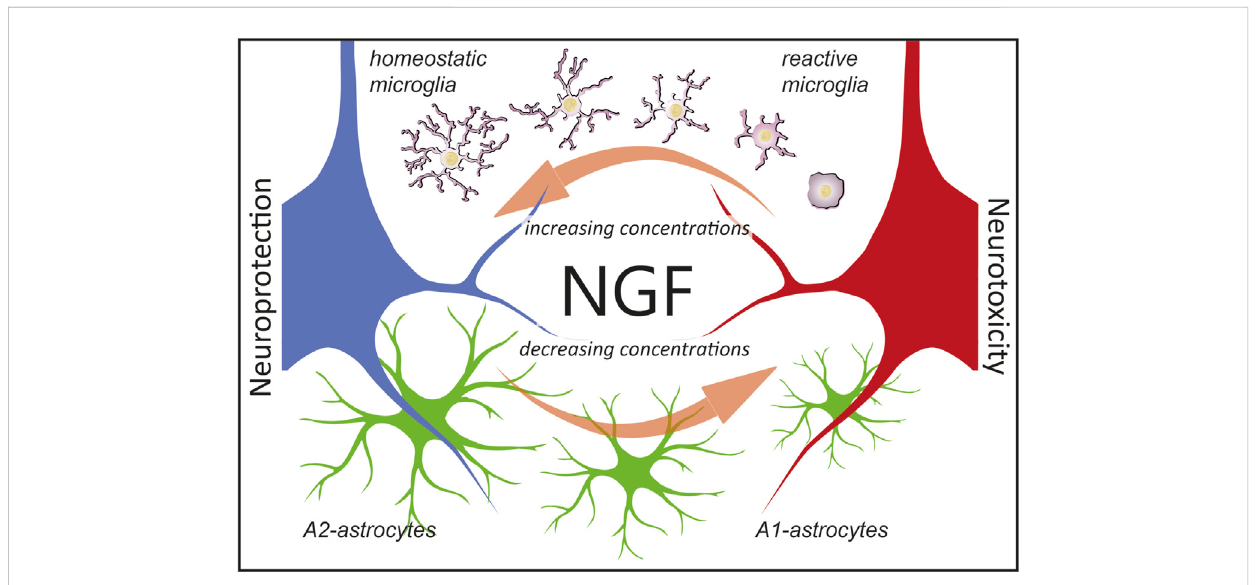
Hypothesis on the consequences of NGF signaling in glial cells. We propose that astrocytes are ambient NGF sensors. NGF levels (which include either mNGF, proNGF, or different ratios thereof) affect glial physiology. In particular, as reported in this work, decreasing concentration of NGF leads to an A1-activationof astrocytes andneurotoxicity (redneuron).On thecontrary, as previously reported (Rizzi et al.,2018), increasing theconcentrations of NGF steers microglia toward an anti-in fl ammatory phenotype, leading to neuroprotection (blue neuron). Of note, de fi ning microglial cells as reactive or homeostatic is an oversimpli fi cation (Paolicelli et al., 2022) and we use such terms merely to indicate the neuroprotective effects of NGF via